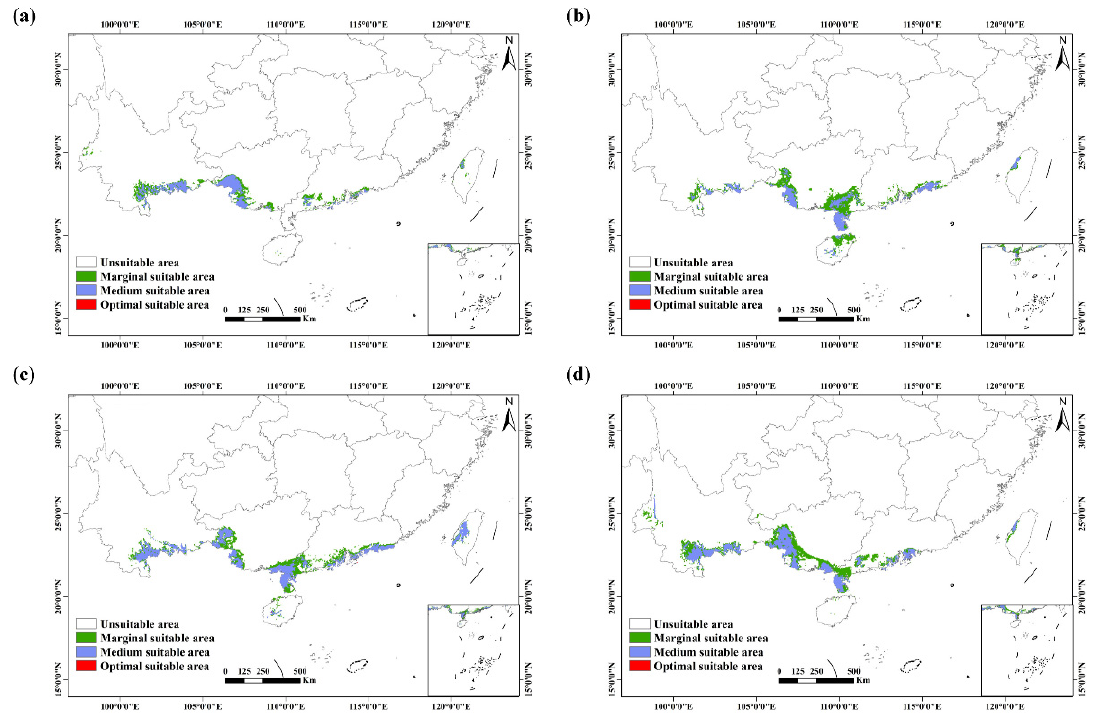
Figure 3. Projected potential distribution maps of H. tetratepala under future periods (2050s) in BCC-CSM2-MR models: ( a ) SSP 2.6, ( b ) SSP 4.5, ( c ) SSP 7.0, and ( d ) SSP 8.5.